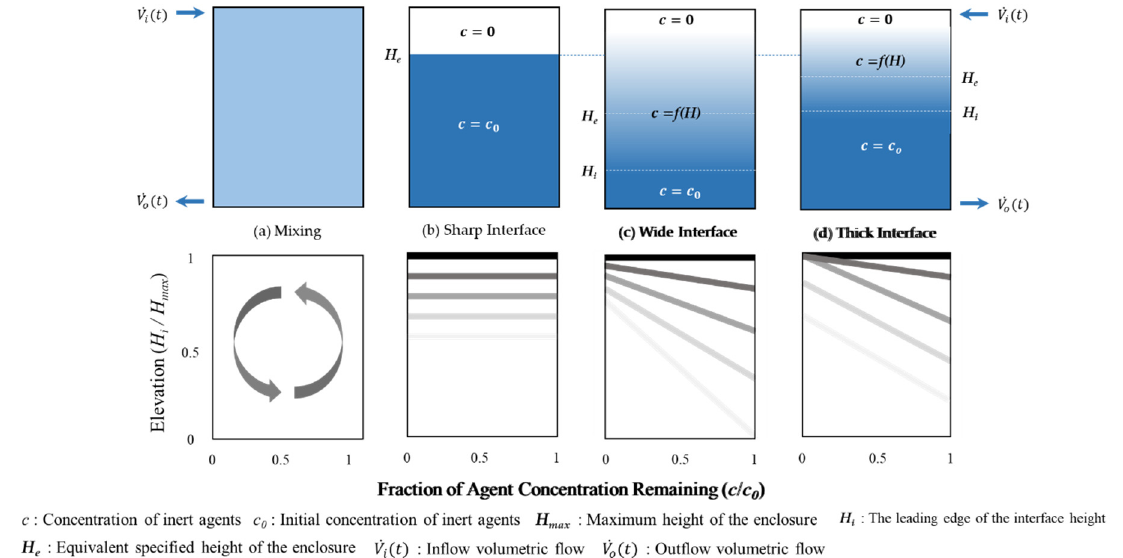
mixing model; ( b ) the sharp descending interface model; ( c ) the wide descending interface model; ( d ) the thick descending interface